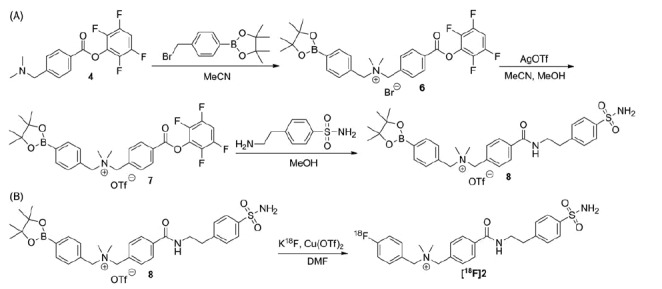
(A) Synthesis of the radiolabeling precursor 8. (B) Synthesis of 18F-labeled 2.